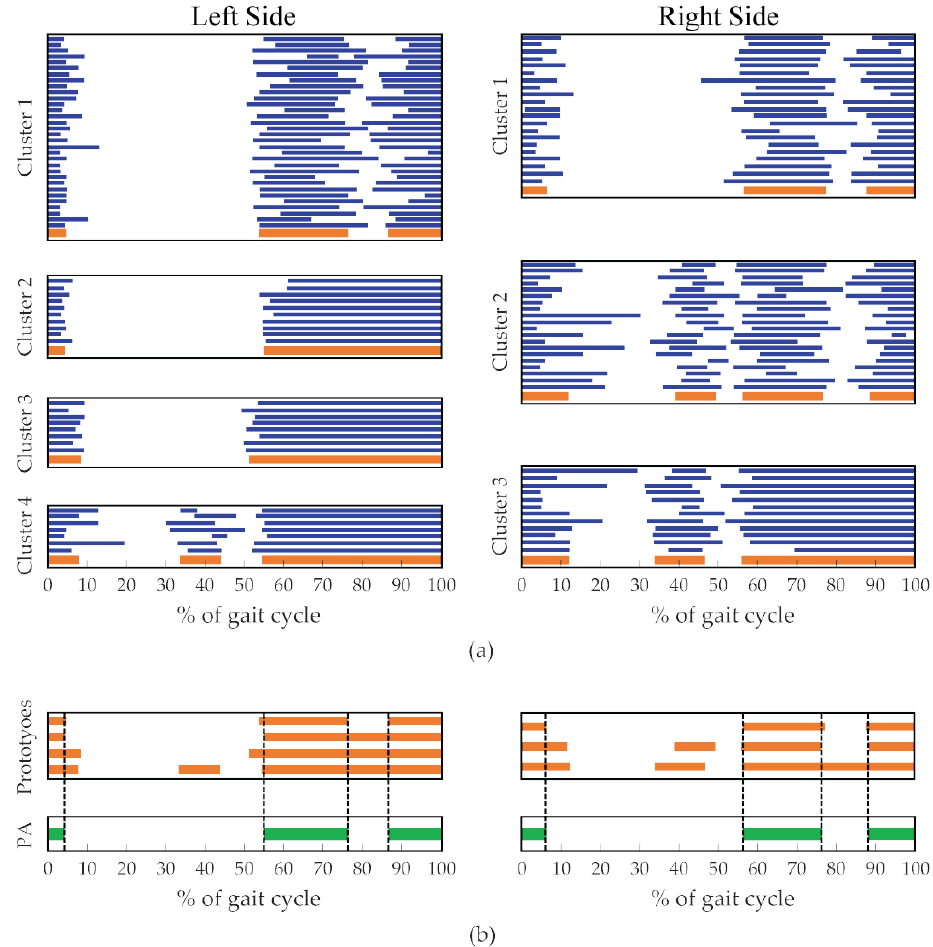
Figure 2. Example of PA extraction (Tibialis Anterior muscle). ( a ) Clusters resulting from the application of CIMAP. Strides belonging to the clusters are represented in blue, clusters’ prototypes are represented in orange. ( b ) PAs, obtained as the intersection of the cluster prototypes, are represented in green.